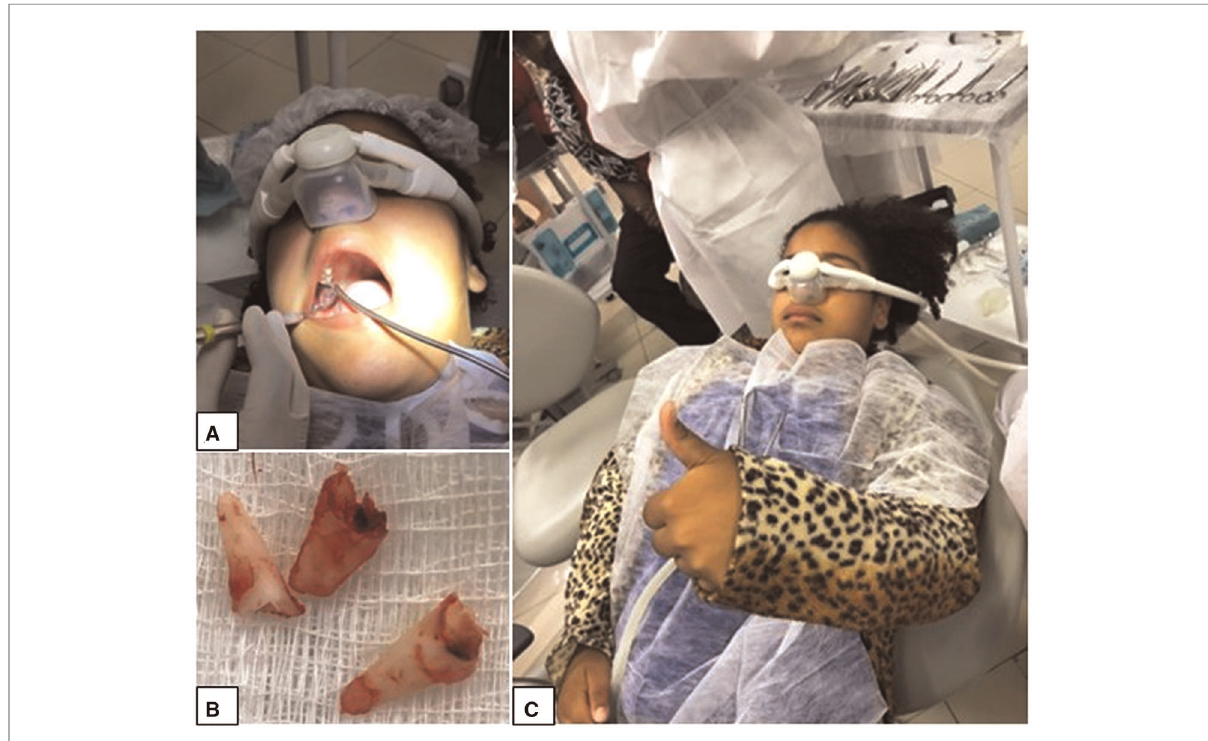
FIGURE 1 ( A ) Beginning of the procedure, with adaptation of the nasal mask, ensuring adequate sedation. ( B ) Extraction of tooth 16 with sectioned roots. ( C ) Patient signaling that everything is fi ne during